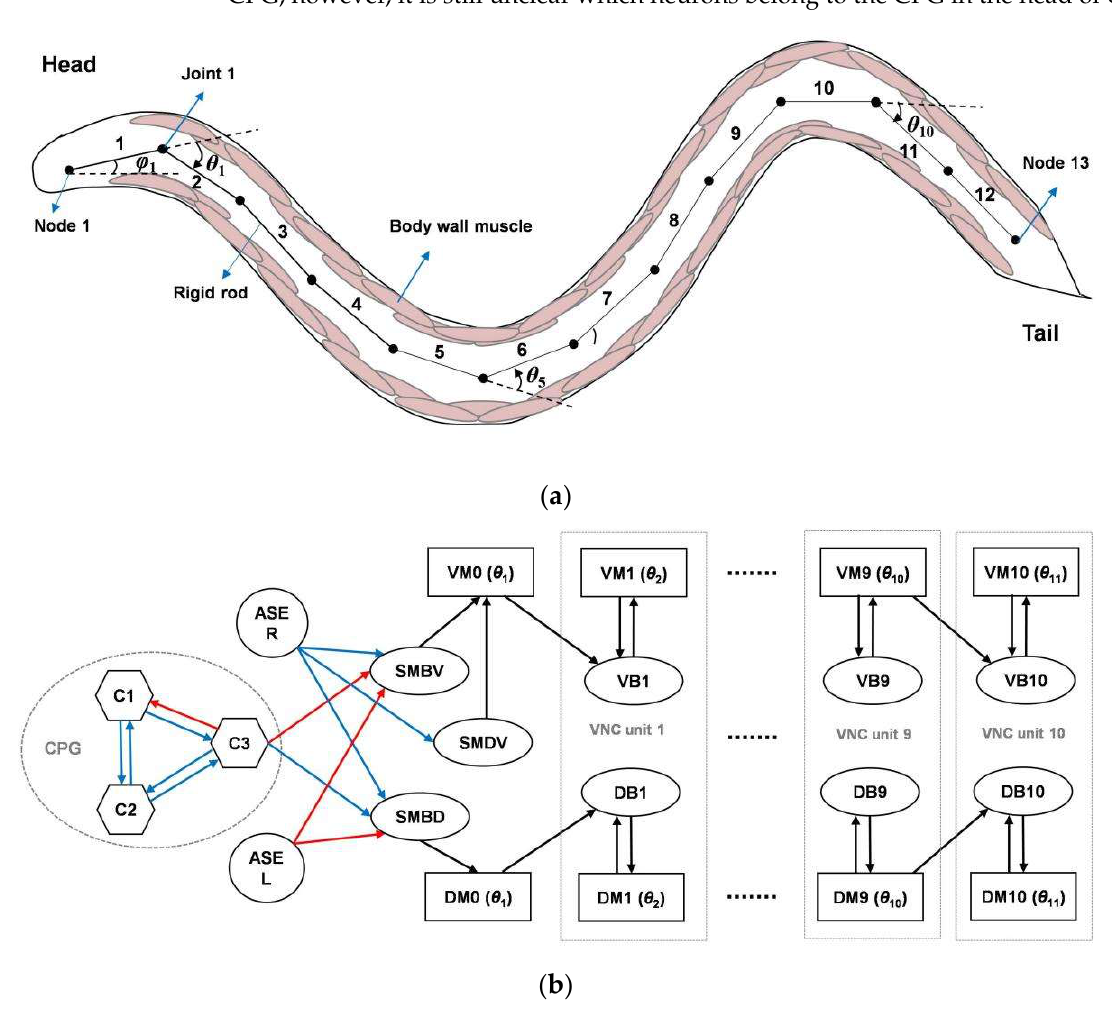
Figure 1. Overall model architecture: ( a ) multi-joint rigid link system abstracted from Caenorhabditis elegans ( C. elegans ) structure; and ( b ) network circuit. The circles, hexagons, ovals, and rectangles represent sensory neurons, oscillatory neurons, motoneurons, and muscle cells, respectively. The blue and red lines represent excitatory and inhibitory neural connections, respectively, where the central pattern generator (CPG) connection polarities were determined through evolution and the rest were specifically designed. The black lines represent neuromuscular connections.